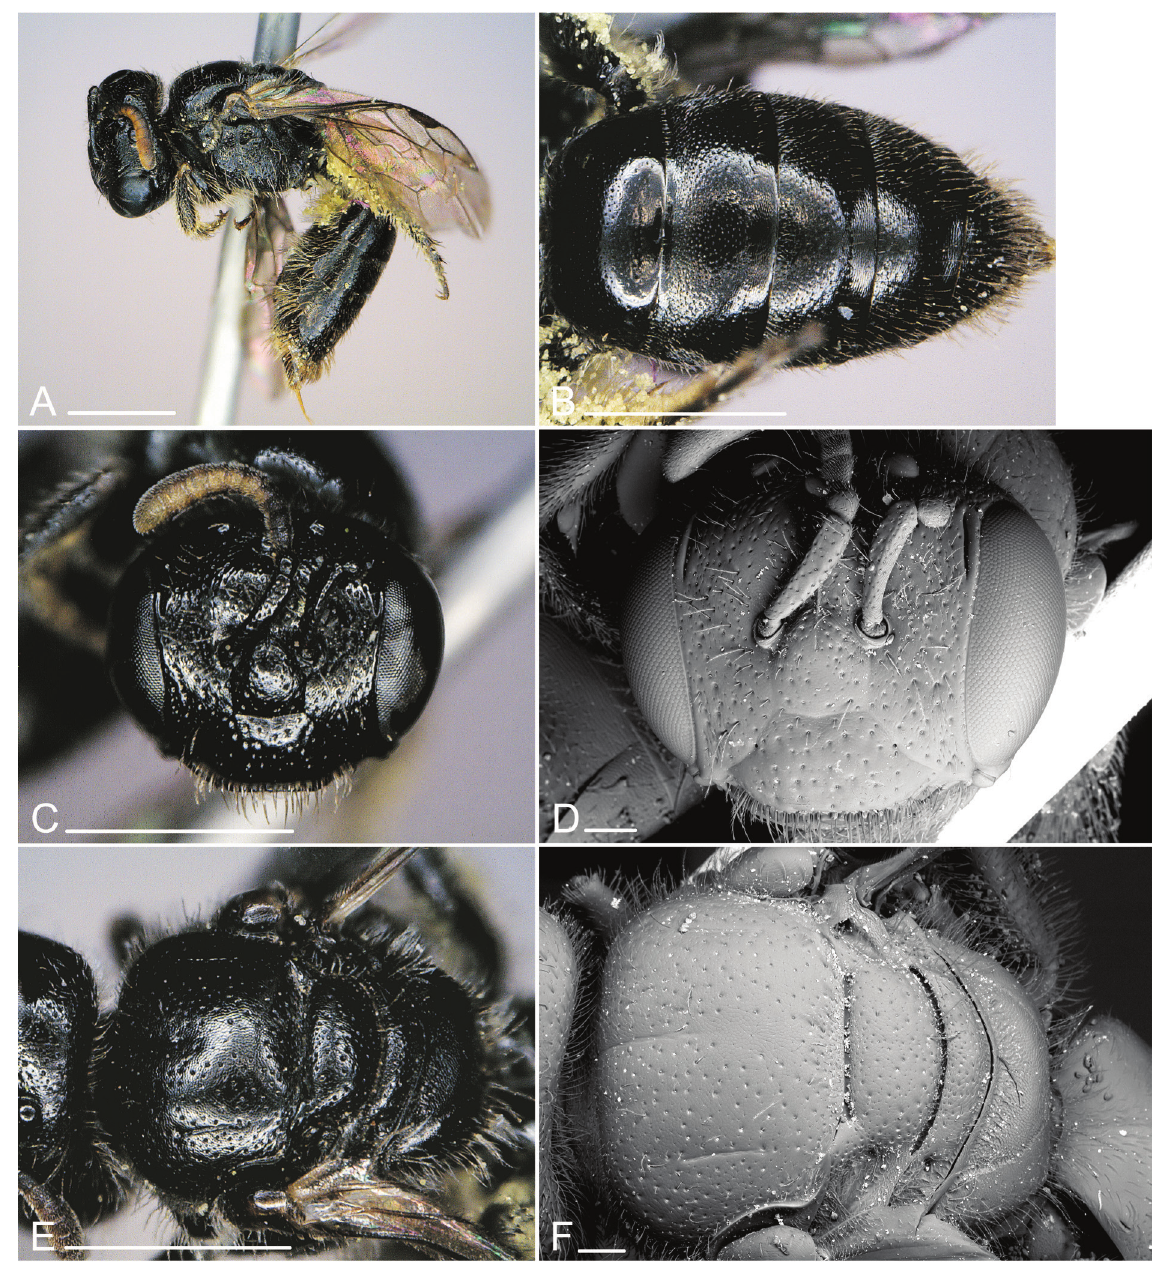
Fig. 14. Scrapter minutuloides sp. nov., ♀. A . Lateral view. B . Metasoma (dorsal view). C . Head. D . Head (SEM). E . Thorax (dorsal view). F . Thorax (dorsal view, SEM). Scale bars: photos: 1 mm, SEM: 0.1